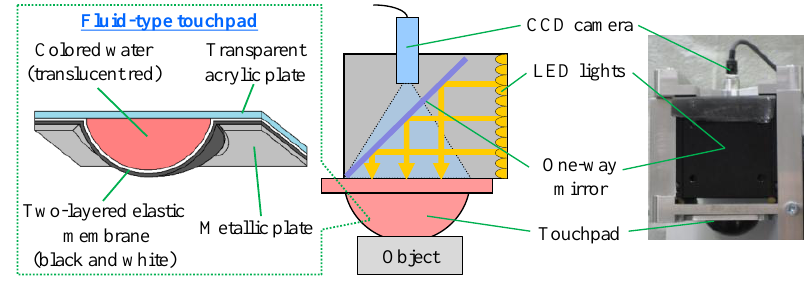
Figure 1. Configuration of the vision-based tactile sensor and the deformable touchpad.